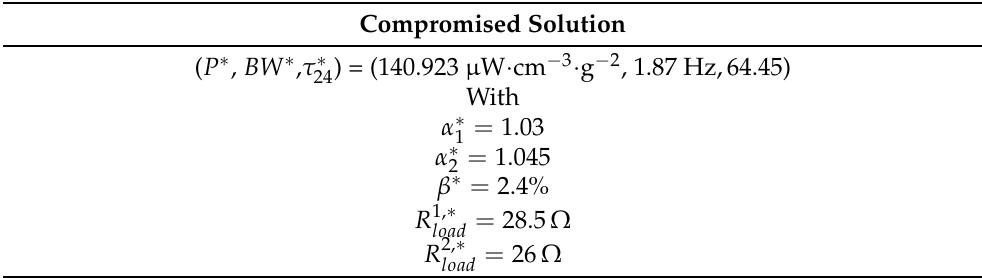
Table 6. Results of the optimization problem of the 5-DOFs